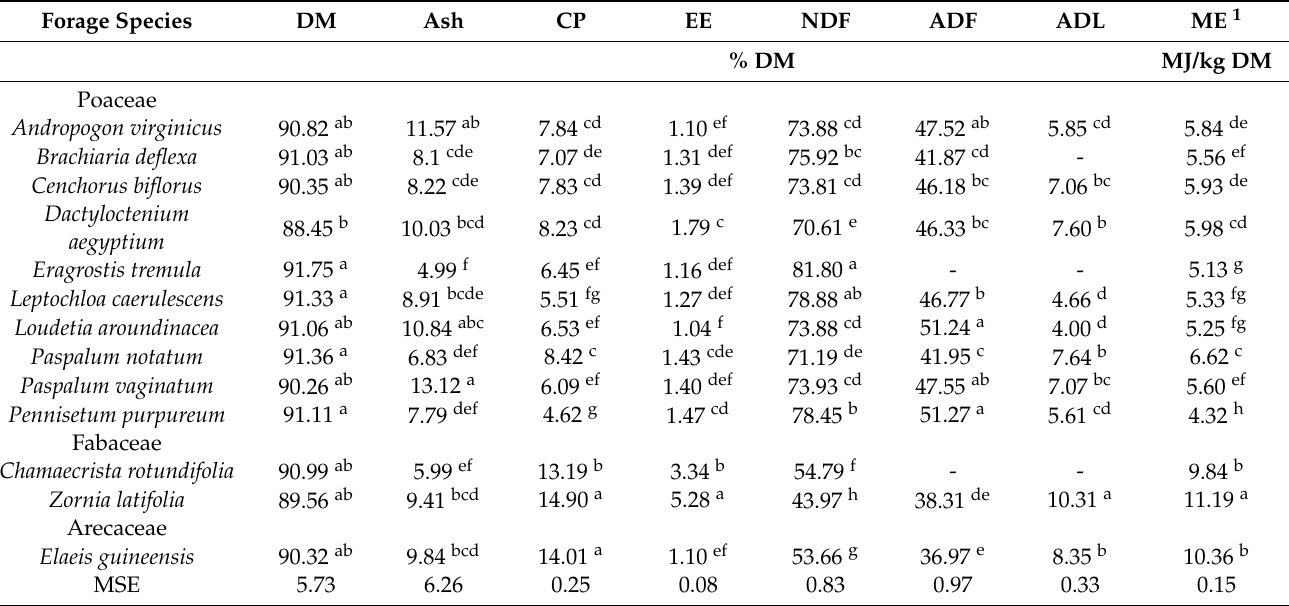
Table 2. Nutritional value of the forage species ( n =